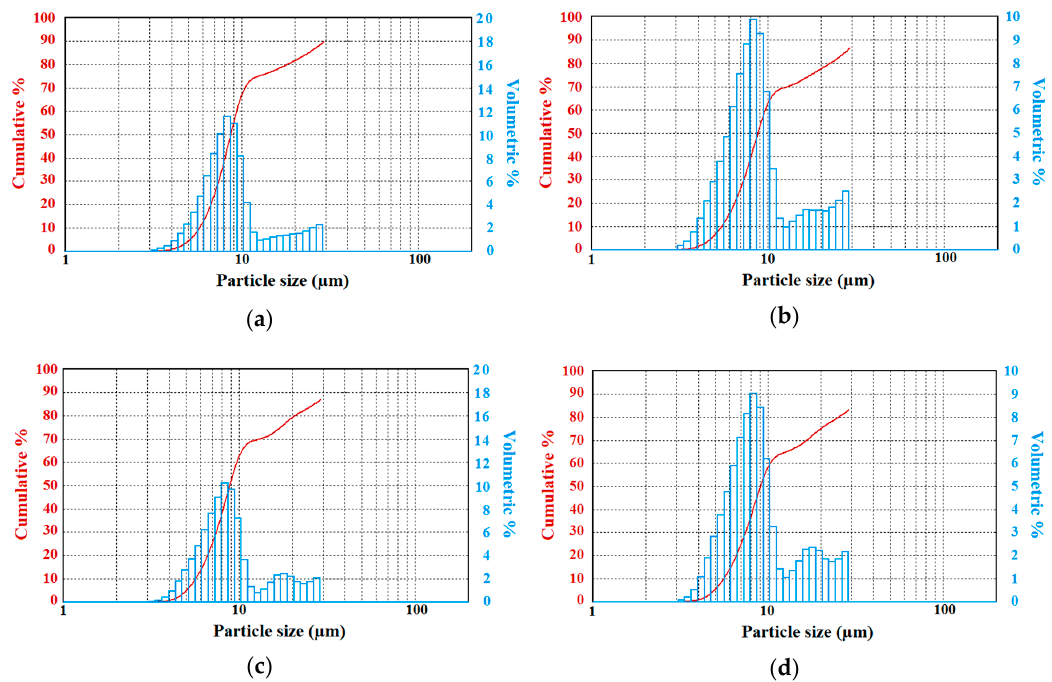
Figure 3. The % of solution contribution to fog spectral volume (right y -axis) and cumulative particle volume concentration (left y -axis) versus droplet diameter ( x -axis) are shown similarly in ( a ), ( b ), ( c ) and ( d ). Averaged fog droplet spectra below 30 μ m containing 2.5%, 5%, 7.5%, and 10% of the amounts of potassium hexacyanoferrate trihydrate (PHT) are shown in ( a ), ( b ), ( c ), and ( d ), respectively.